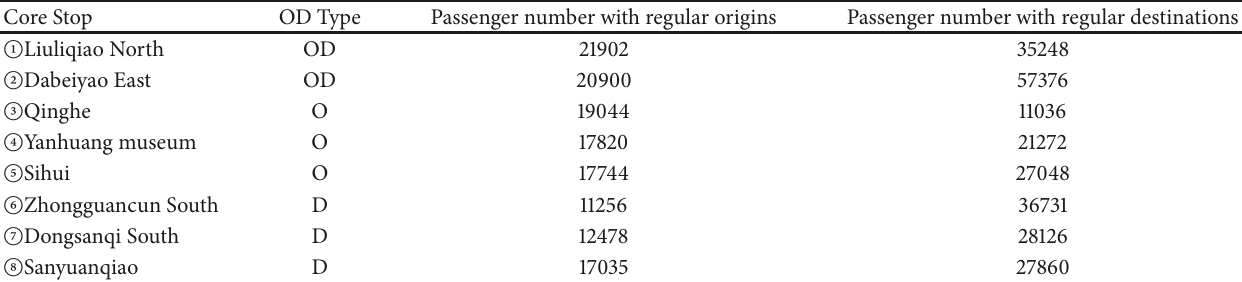
Table 3: Detail data for the top five origin areas and the top five destination areas in the morning.